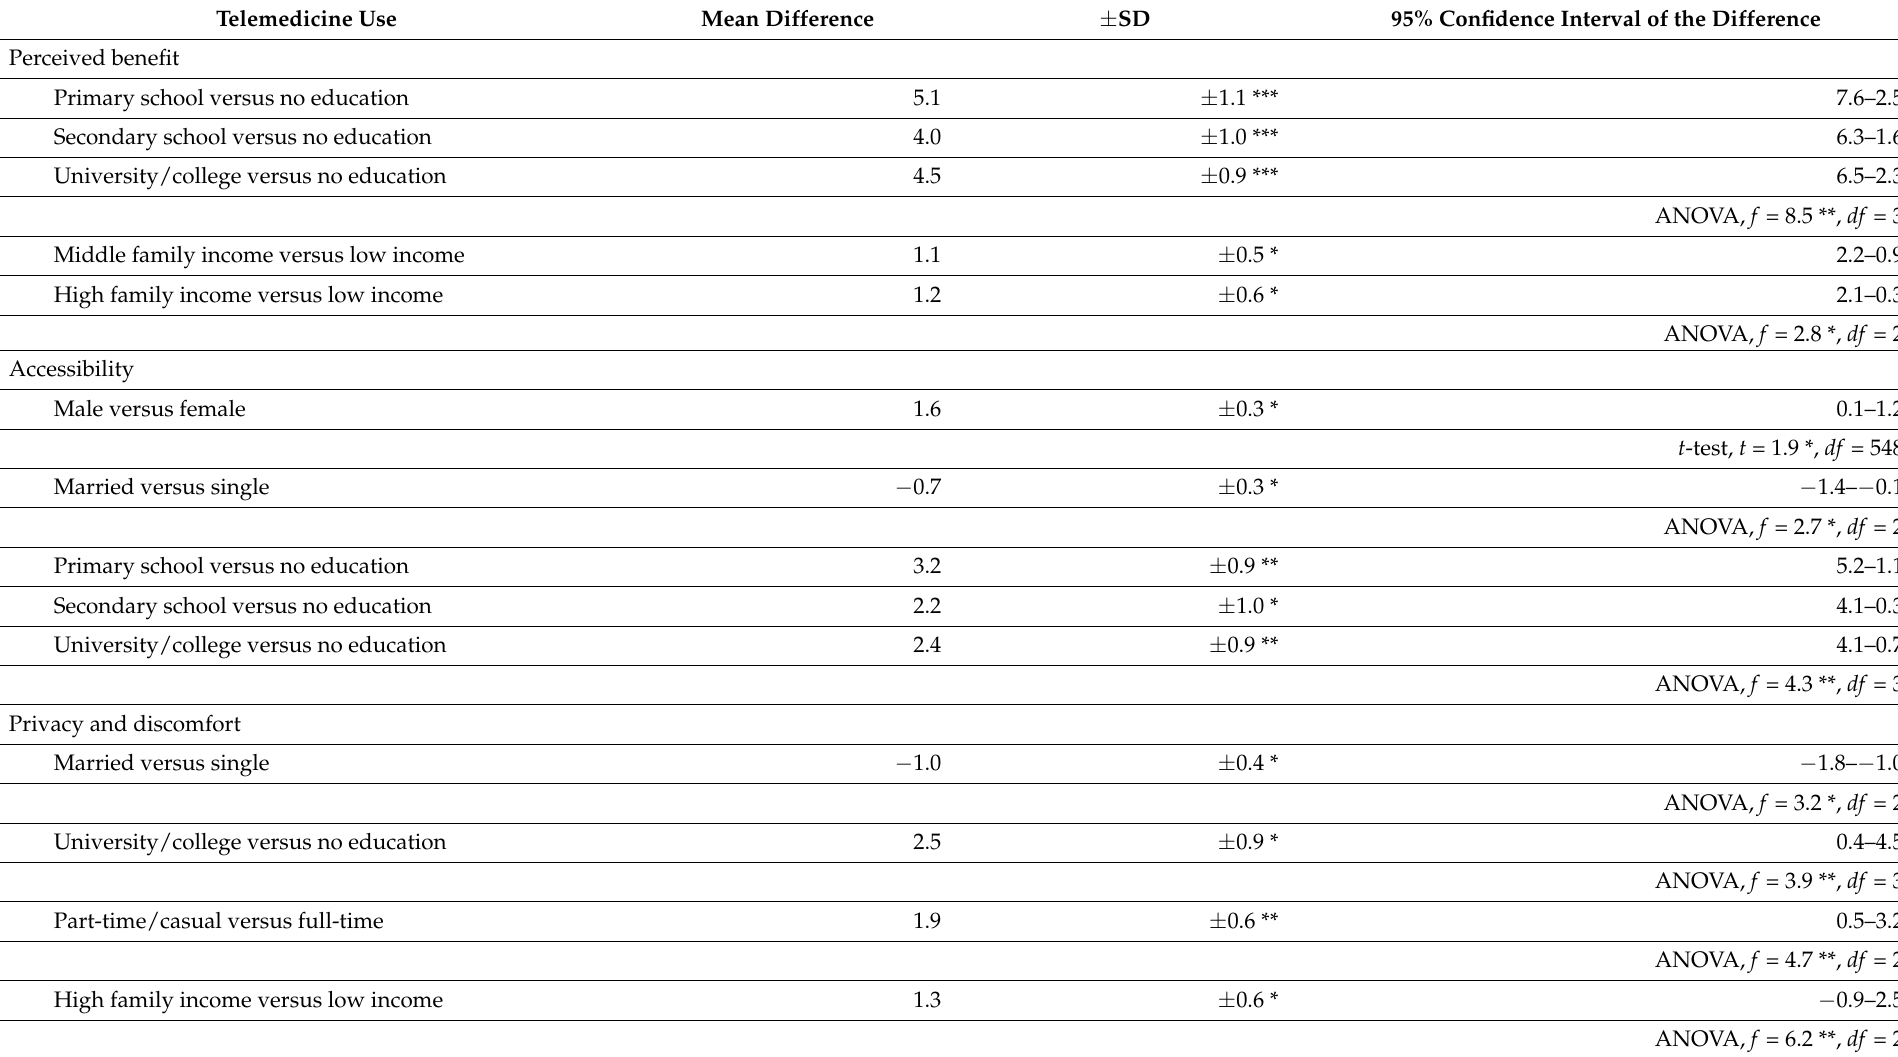
Table 4. Comparison of telemedicine domains across significant demographic variables ( n =